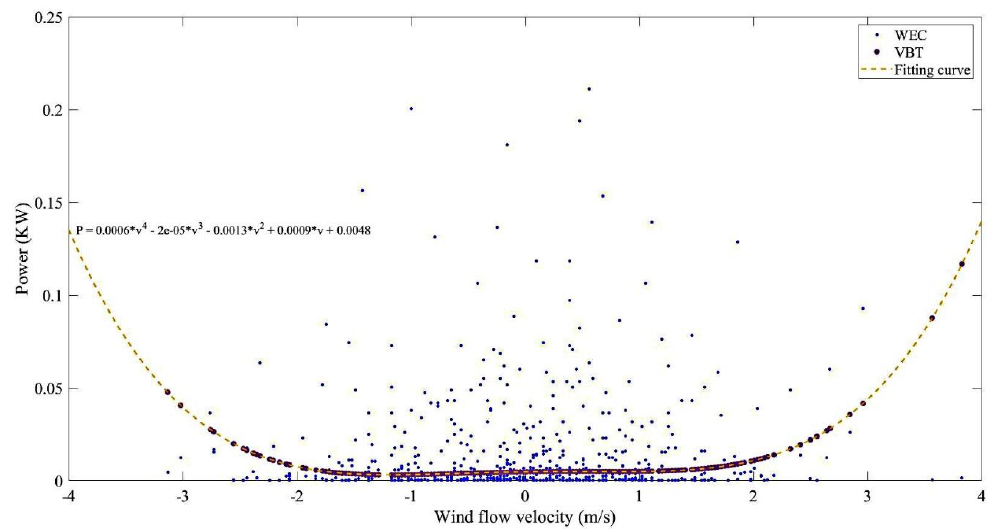
Figure 7. Generated power of WEC and VBT by the curve fitting.